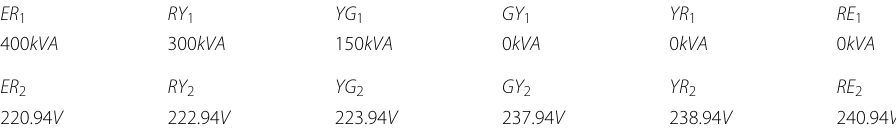
Table 3 The thresholds of the overloading KPI class (first part) and the voltage KPI class (second part) ER 1 RY 1 YG 1 GY 1 YR 1 RE 1 400 kVA 300 kVA 150 kVA 0 kVA 0 kVA ER 2 RY 2 YG 2 GY 2 220.94 V